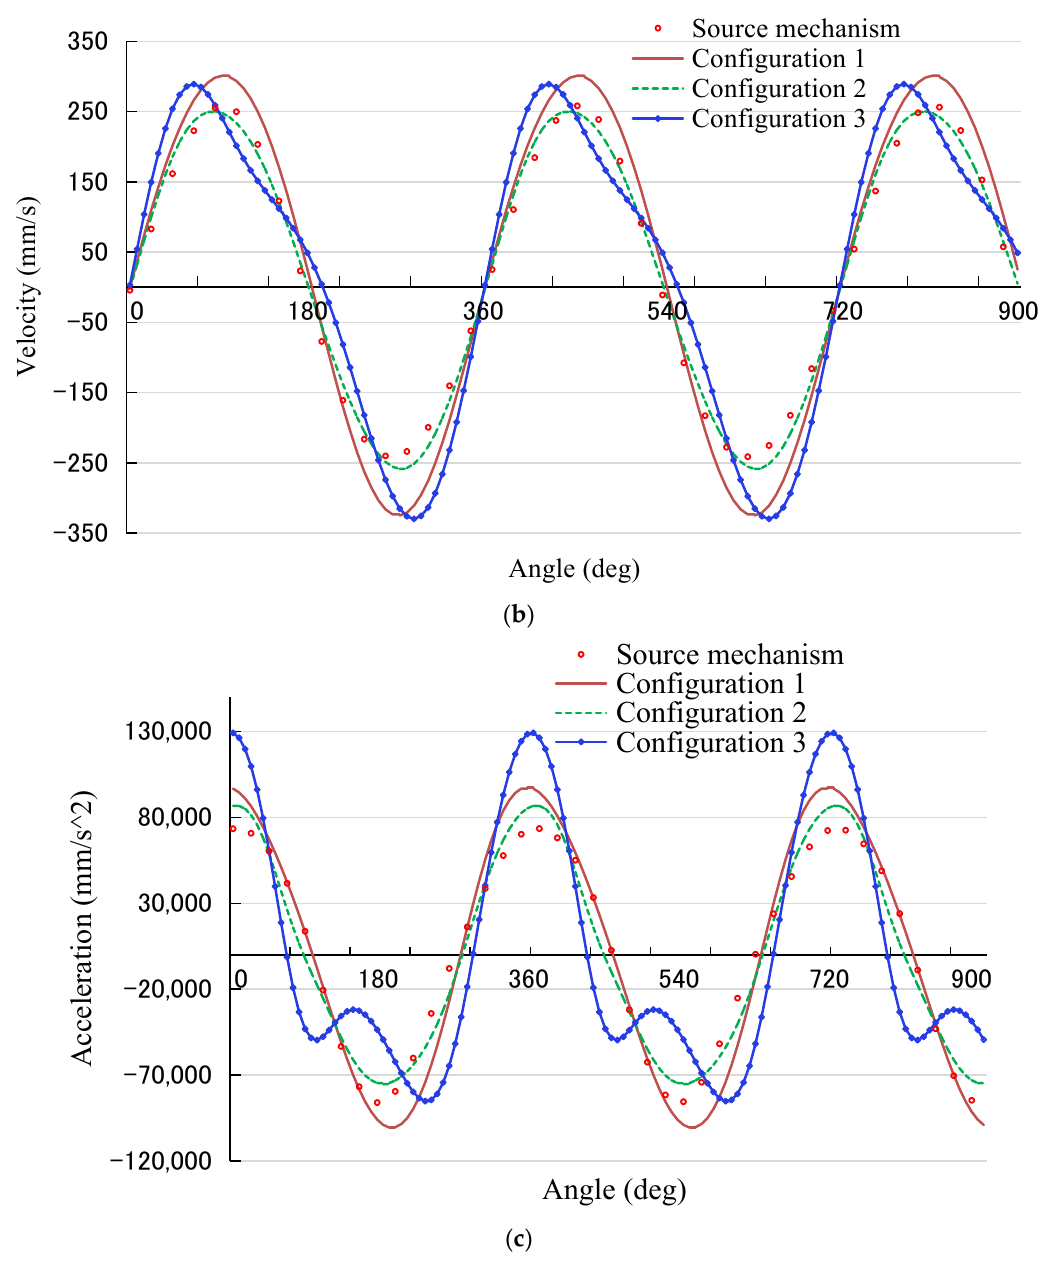
Figure 14. Upward and downward movement curves of the feed dog. ( a ) Upward and downward movement displacement, ( b ) movement velocity, and ( c ) movement acceleration of the feed dog. The amount of forward and backward movement of the feed dog is proportional to the sewing needle distances. For a lockstitch sewing machine, the increasing needle distance leads to a decreasing in the rising slope and the pressure of the presser foot, resulting in the effective sewing efficiency. In Figure 13a, the forward and backward displacement of mechanism configuration 1 is the smallest, approximately 1.23 mm, indicating that the sewing needle distance is the smallest. The displacements of mechanism configurations 2 and 3 are relatively larger; configuration 2 has the largest displacement of 5.33 mm, and configuration 3 has a displacement of 4.45 mm. The forward and backward displacement of configuration 2 is 67.4% higher than that of the source mechanism. This can be explained by slider assembly being used for the source mechanism and mechanism configuration 1, and link assembly being used for the mechanism configurations 2 and 3. The slider